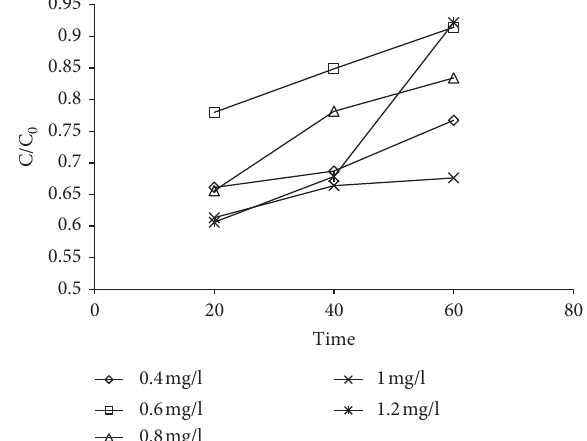
Figure 6: Effect of initial trifluralin concentration on process ef- ficiency (ZnO concentration, 100mg/L, pH � 9, UV �